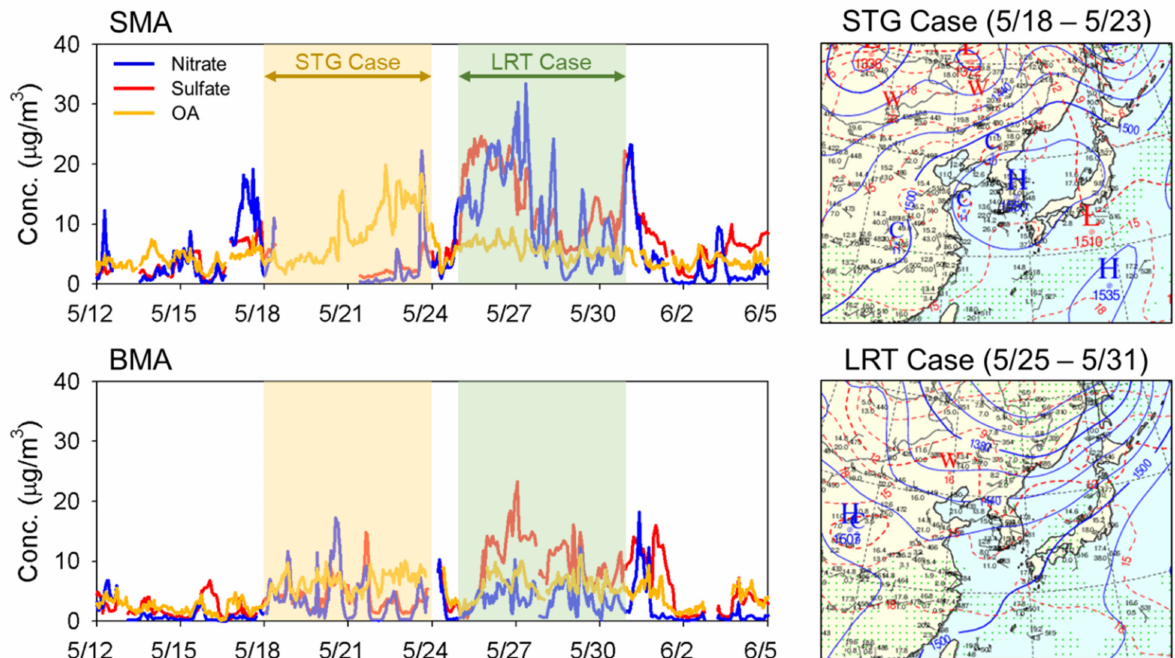
Figure 5. Time series of chemical components of PM 2.5 over periods of stagnant and long-range transport during KORUS- AQ. Synoptic maps for both periods are also shown. Two 850 hPa synoptic maps from 18 May (right, top) and 25 May (right, bottom) are also shown as representative days for both